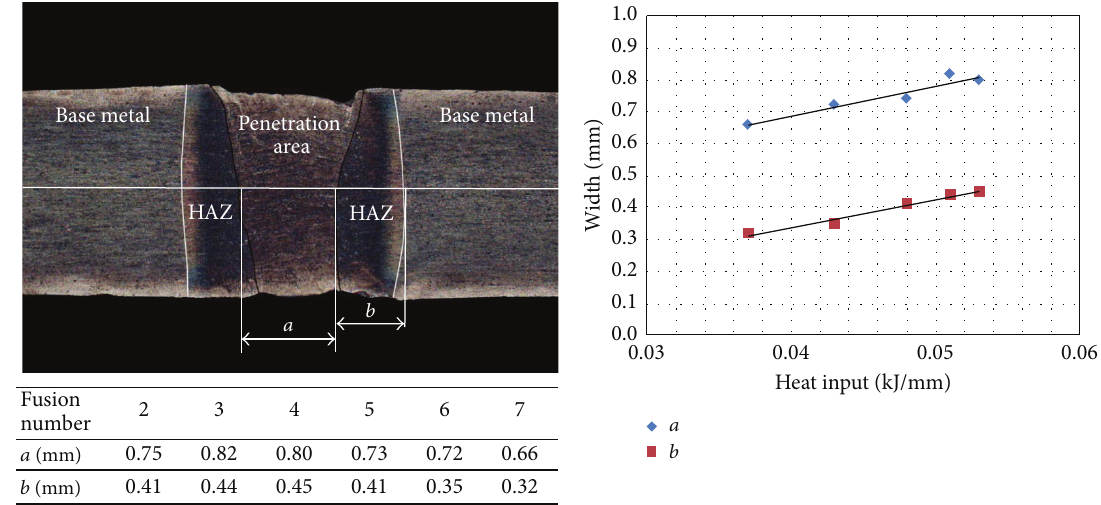
Figure 2: Area of measurement of penetration width and HAZ width in tested samples and measurement results.